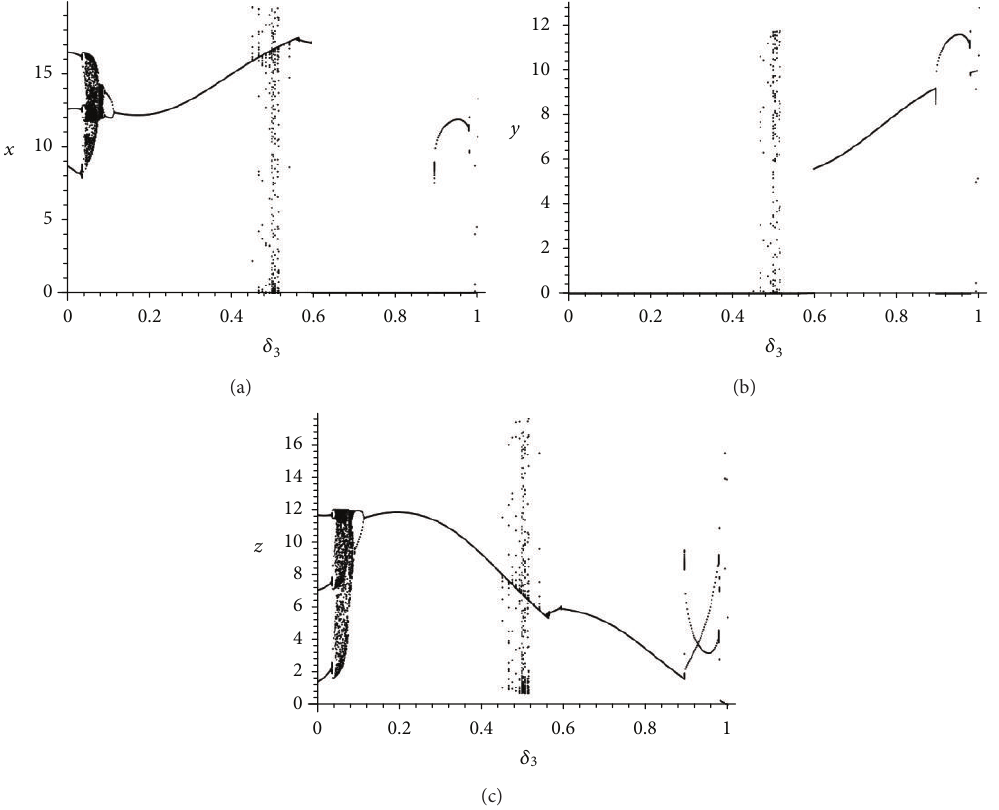
Figure 4: Bifurcation diagram of the system (1) with 0 ≤ 𝛿 3 ≤ 1